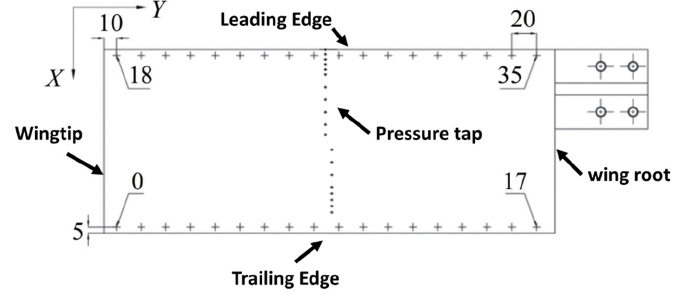
Figure 12. Measurement principle of the video grammetric model deformation (VMD) system. the longitudinal interval was 5 mm.